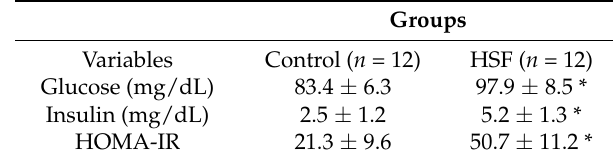
Table 2. Effect of high-sugar and high-fat (HSF) diet on plasma metabolic parameters.